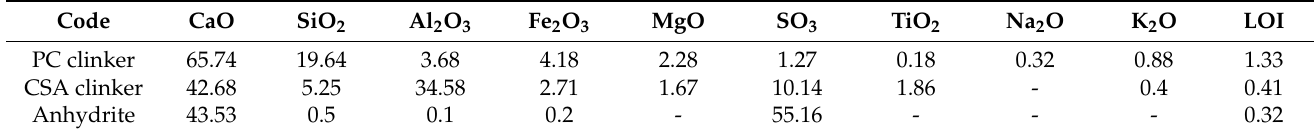
Table 1. Chemical composition of cement (wt.%).